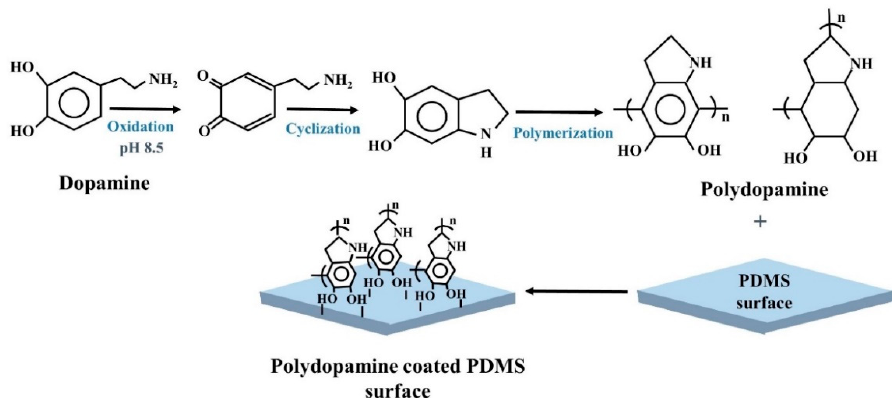
Figure 4. Schematic presentation of dopamine polymerization mechanism and PDMS surface modification by Polydopamine.